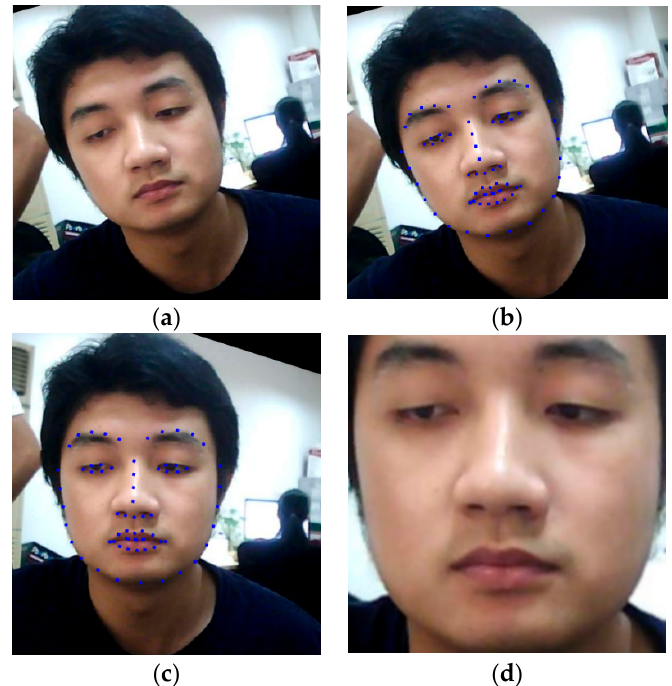
Figure 2. Demonstration of our preprocessing step: ( a ) input face image from NUAA dataset [16]; ( b ) detected face region on input face image using ERT method; ( c ) face region is aligned using center points of face, left and right eyes; ( d ) final extracted face region.